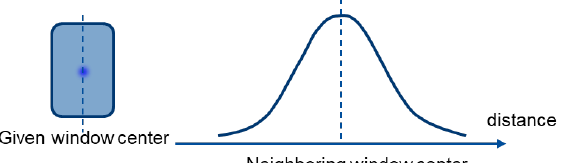
Figure 5. The probabilistic distribution of the distance to the neighboring window on the right.